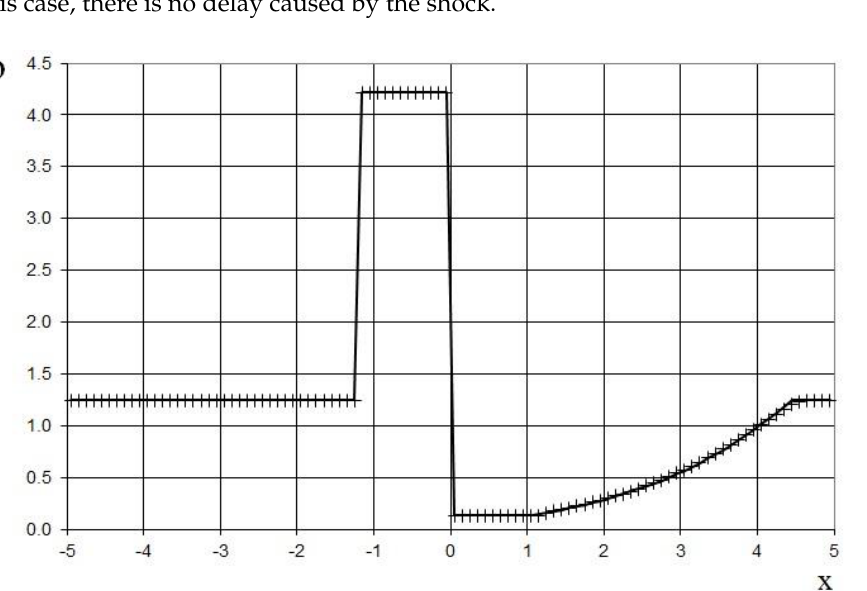
Figure 28. Pressure plot for the problem (53): the exact solution (line), and the present method (cross).